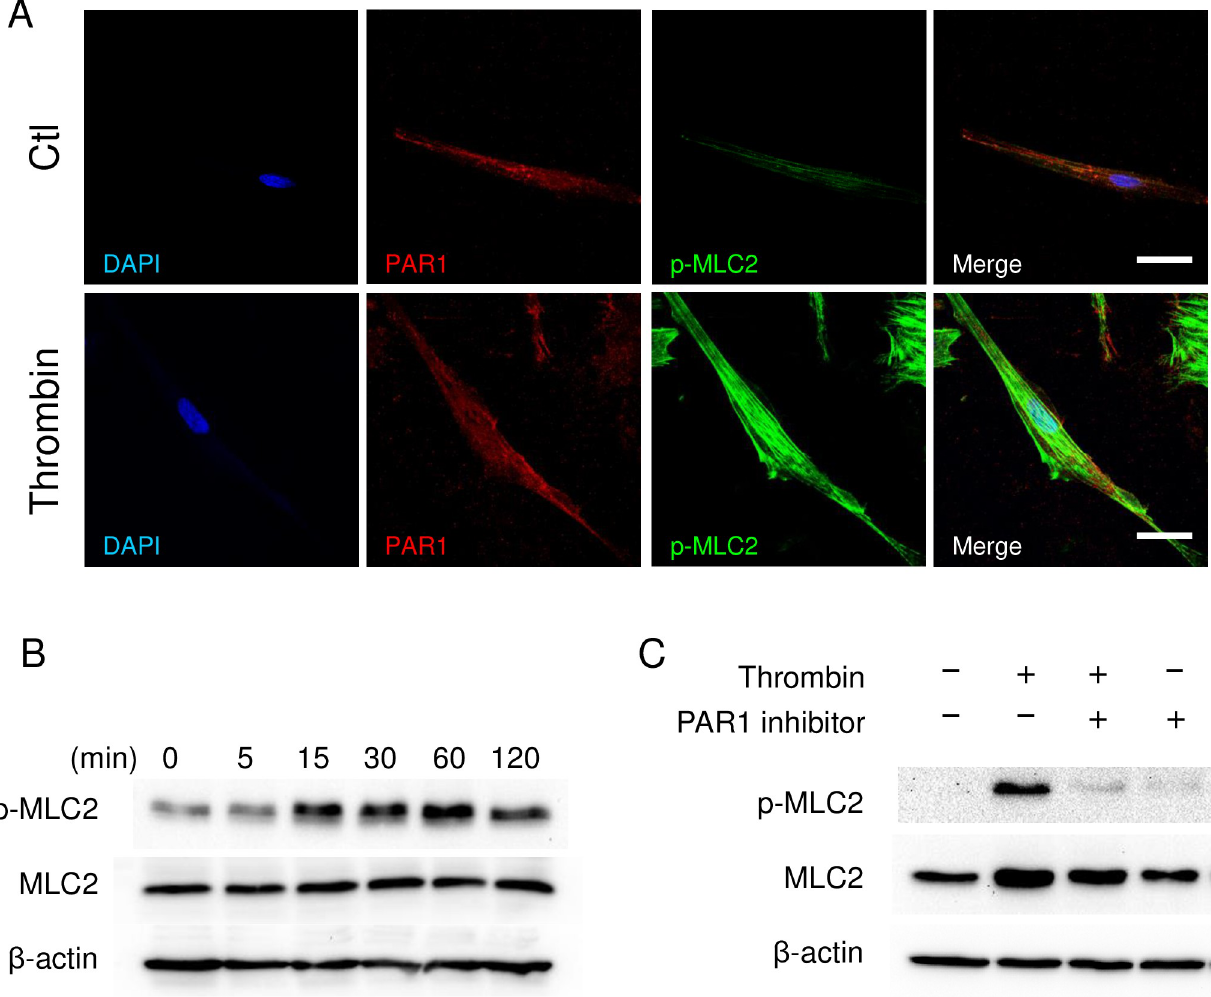
Fig 3. Thrombin activates acto-myosin interaction by phosphorylation of myosin light chain-2 (MLC2). (A) Immunocytochemistry of PAR1 (red) and phosphorylated MLC2 (Ser19, green) in human myometrial cells. (B, C) Immunoblots of phosphorylated MLC2 (p-MLC2), total MLC2, and β -actin of myometrial cells. Myometrial cells were treated with thrombin (2 U/mL) as a function of time (B) , or pretreated with 100 nM PAR1 inhibitor (SCH79797) for 1 h, and then treated with 2 U/mL of thrombin for 30 min (C) . The experiments were repeated three times.